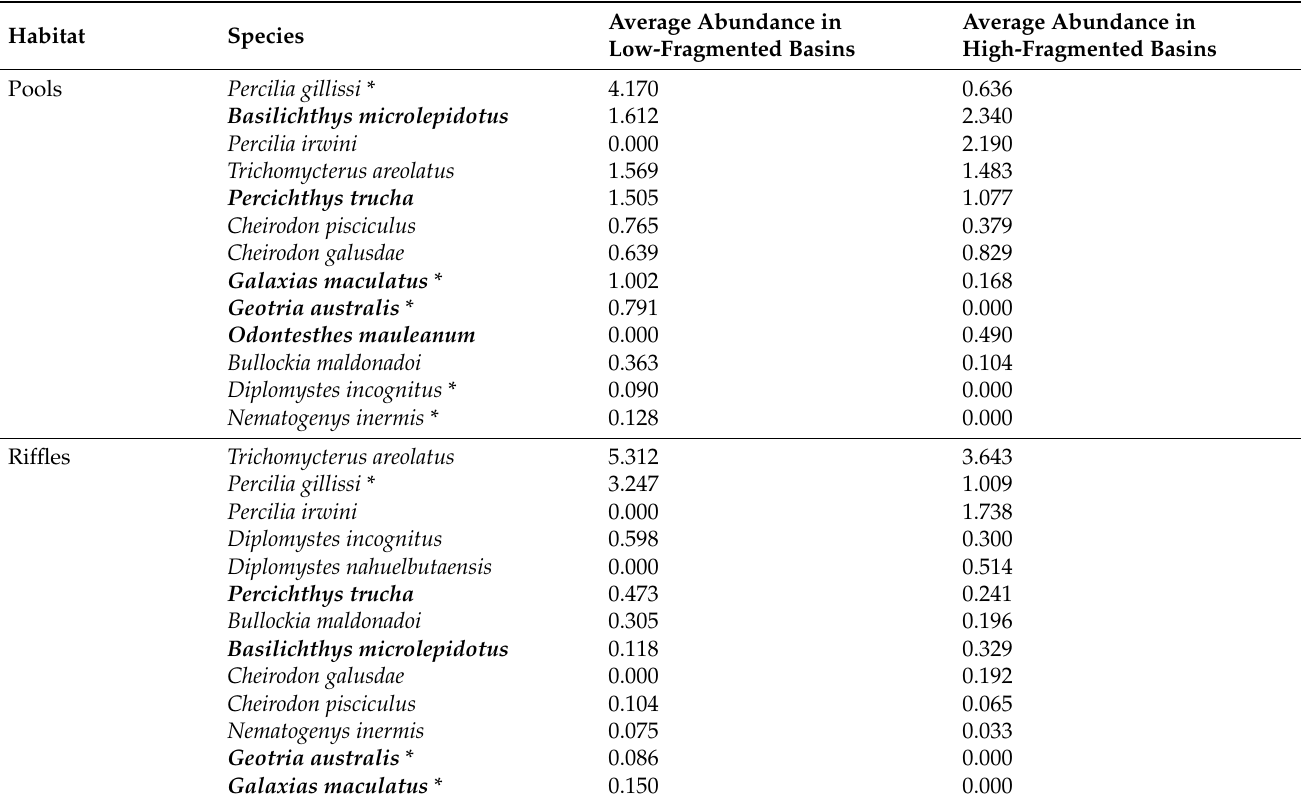
Table 3. Transformed average abundances of native species present in the eight basins studied according to level of fragmentation. Species were ordered according to absolute differences in abundances. High-dispersal capacity species appear in bold, while species with significant differences in average abundances are indicated with an asterisk